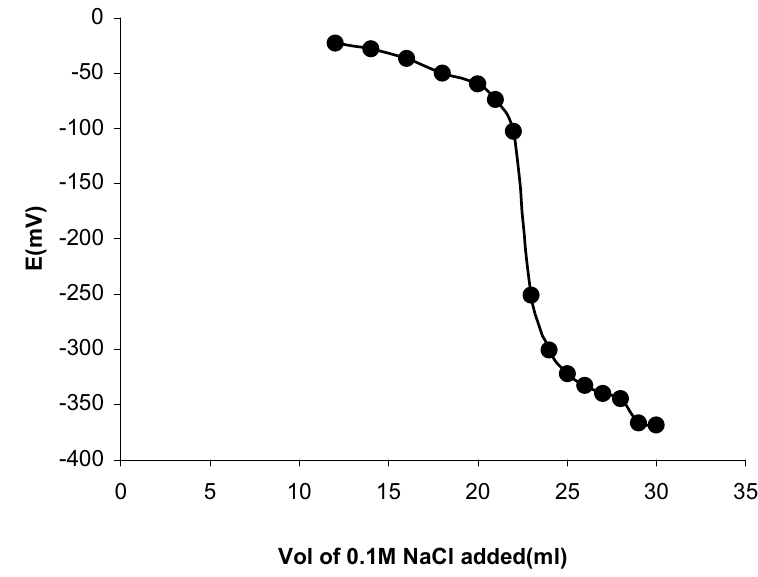
with 1.0 × 10 -1 M 3